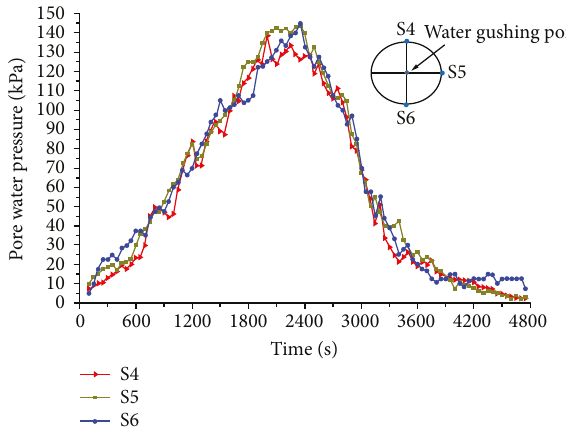
Water gushing point